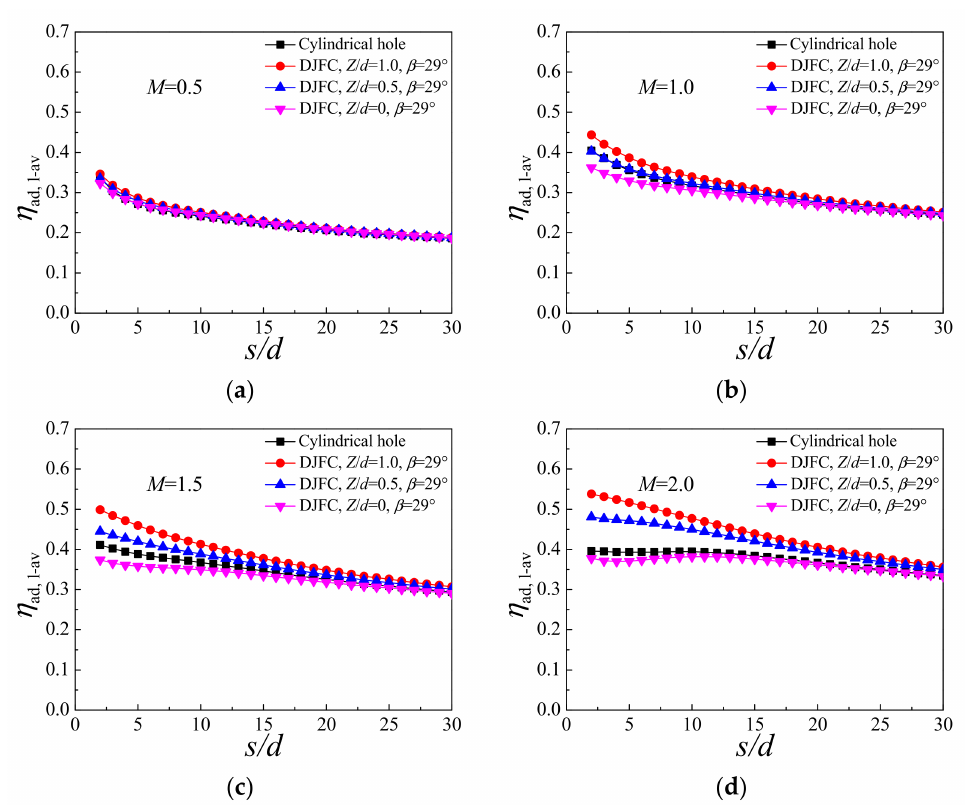
Figure 17. Laterally averaged film cooling effectiveness on the suction surface. ( a ) M = 0.5, ( b ) M = 1.0, ( c ) M = 1.5, ( d ) M =